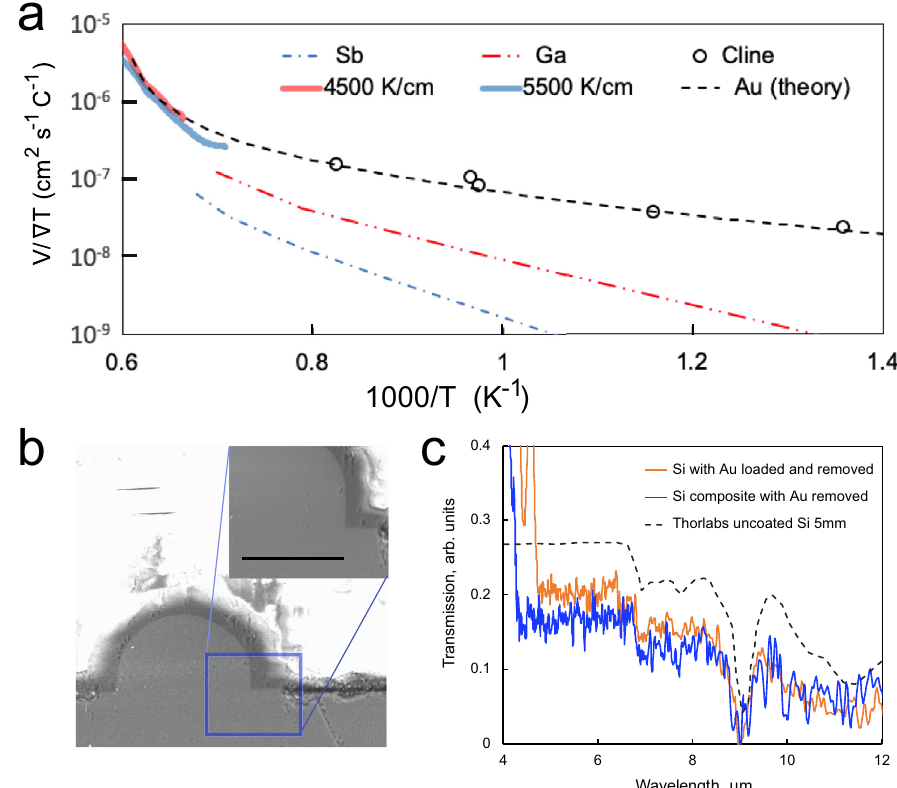
Fig. 2 Thermomigration of Au in Si. a Calculated and experimental alloy droplet velocity in silicon normalised by the temperature gradient in the host, as a function of 1/ T for several metals. Theory and data for Au in Si after Cline and Anthony 39,52 , with experimental data from two droplets in the present study (solid lines-orange for the gradient of 4500 K cm − 1 and blue for the gradient of 5500 K cm − 1 ). b Si fi bre core welded to a single crystal Si substrate (using geometry of Fig. 1e) after thermomigration removal of a thin Au layer at the interface (inset close-up of weld region, scale bar 50 µ m), and ( c ) Infrared transmission of Si fi bres after removal of gold that was introduced by thermomigration (orange) and that was included in the preform when drawing the fi bre (blue). The black dashed curve shows a scaled transmission pro fi le of a 5 mm thick uncoated Si window (Thorlabs), to allow comparison of spectral